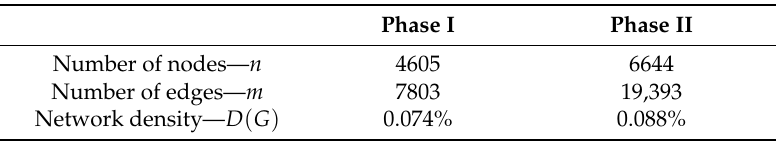
Table 3. Overall size of the carbon trading